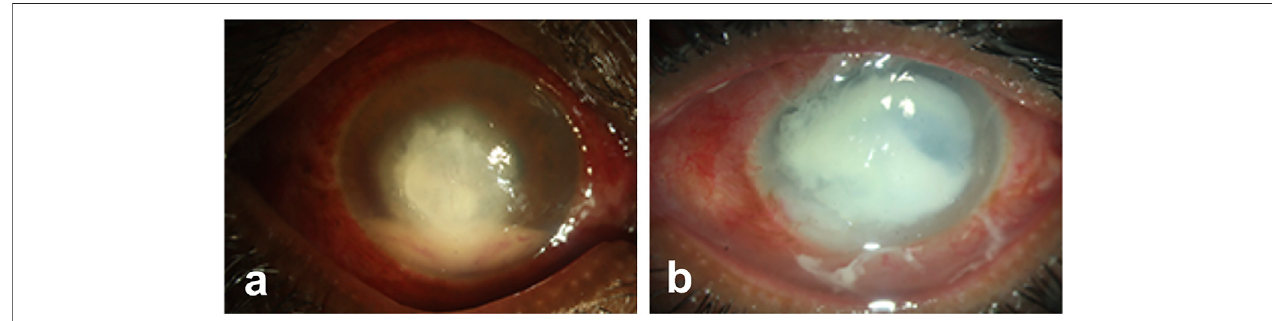
FIGURE 1 | Representative images of microbial keratitis. The pathogens causing infections penetrates deep into the stroma inducing in fl ammation and corneal opacity that leads to loss of